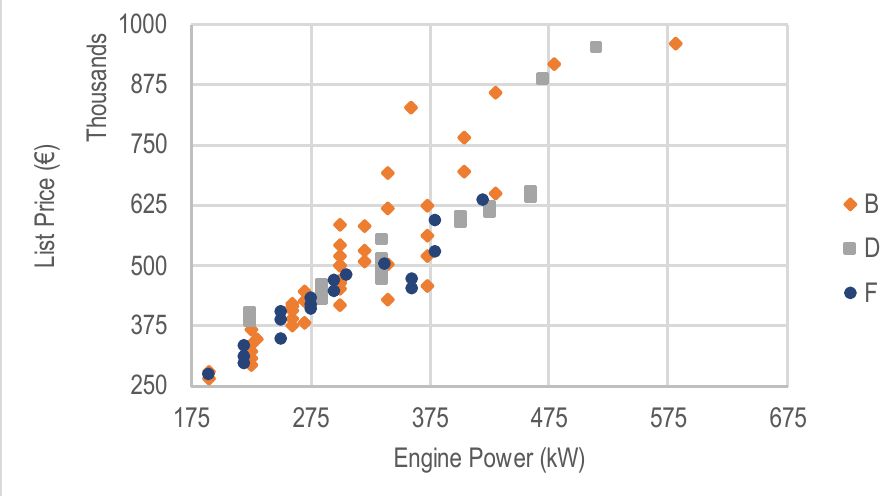
Figure 2. Grain harvesting combine list prices in Germany.